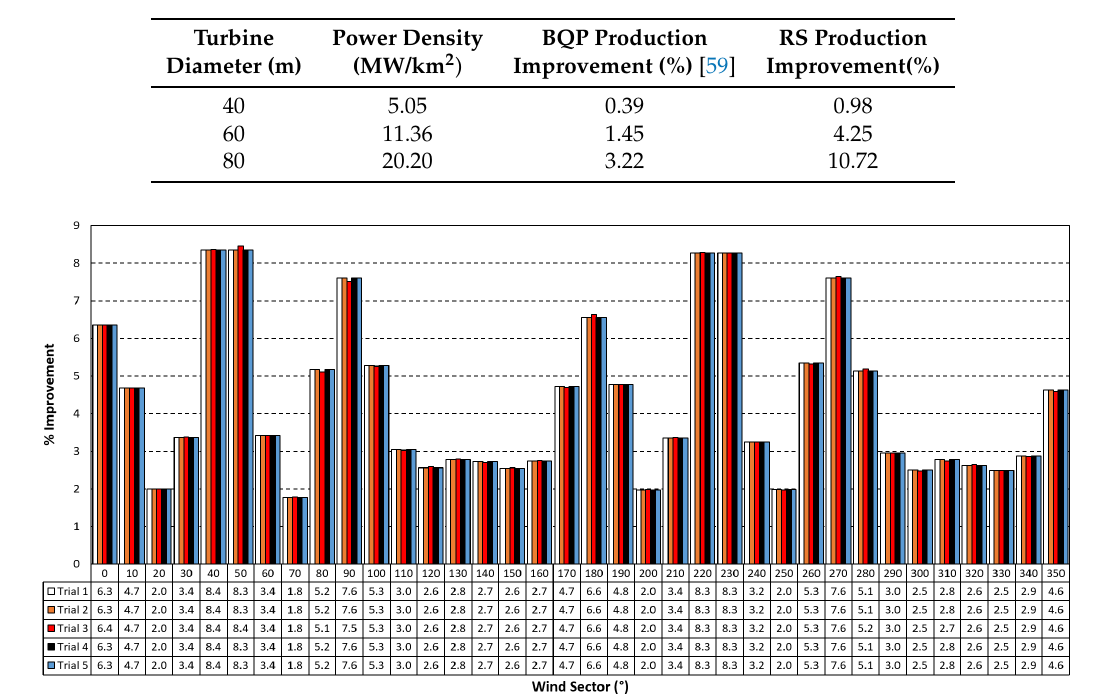
Table 4. Power density and percent production improvement of layout from Grady et al. [60] using binary quadratic programming (BQP) model [59] compared with proposed random search (RS) algorithm.